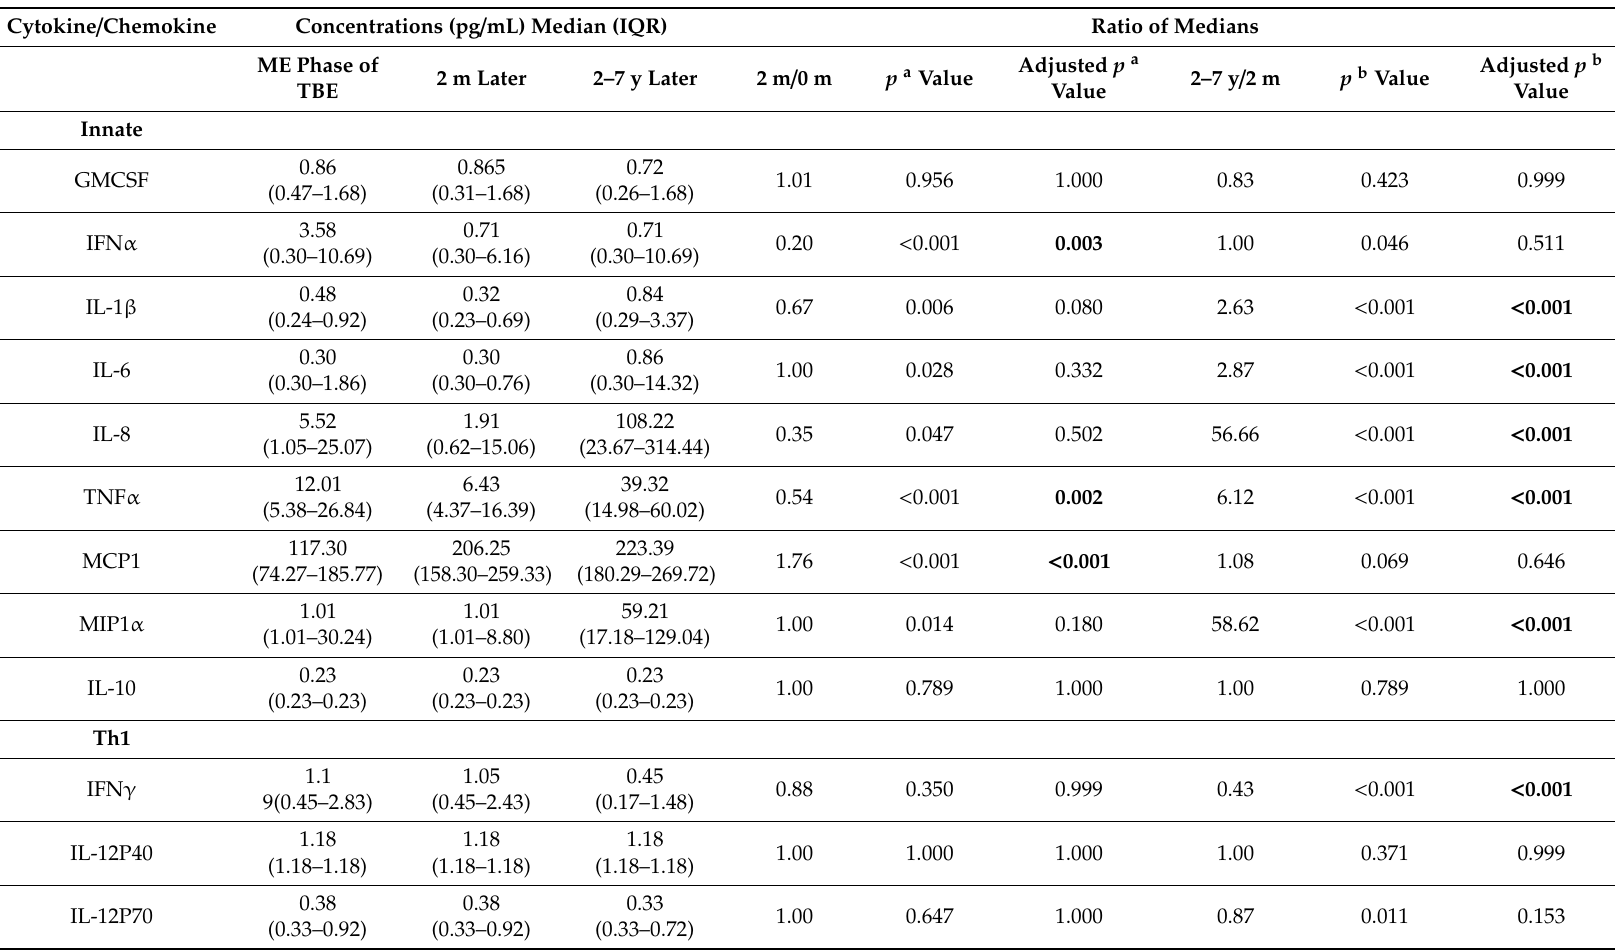
Table 2. Serum concentrations of cytokines / chemokines obtained in patients with tick-borne encephalitis early in the meningoencephalic phase of the illness, and at follow-up visits 2 months and 2–7 years after tick-borne